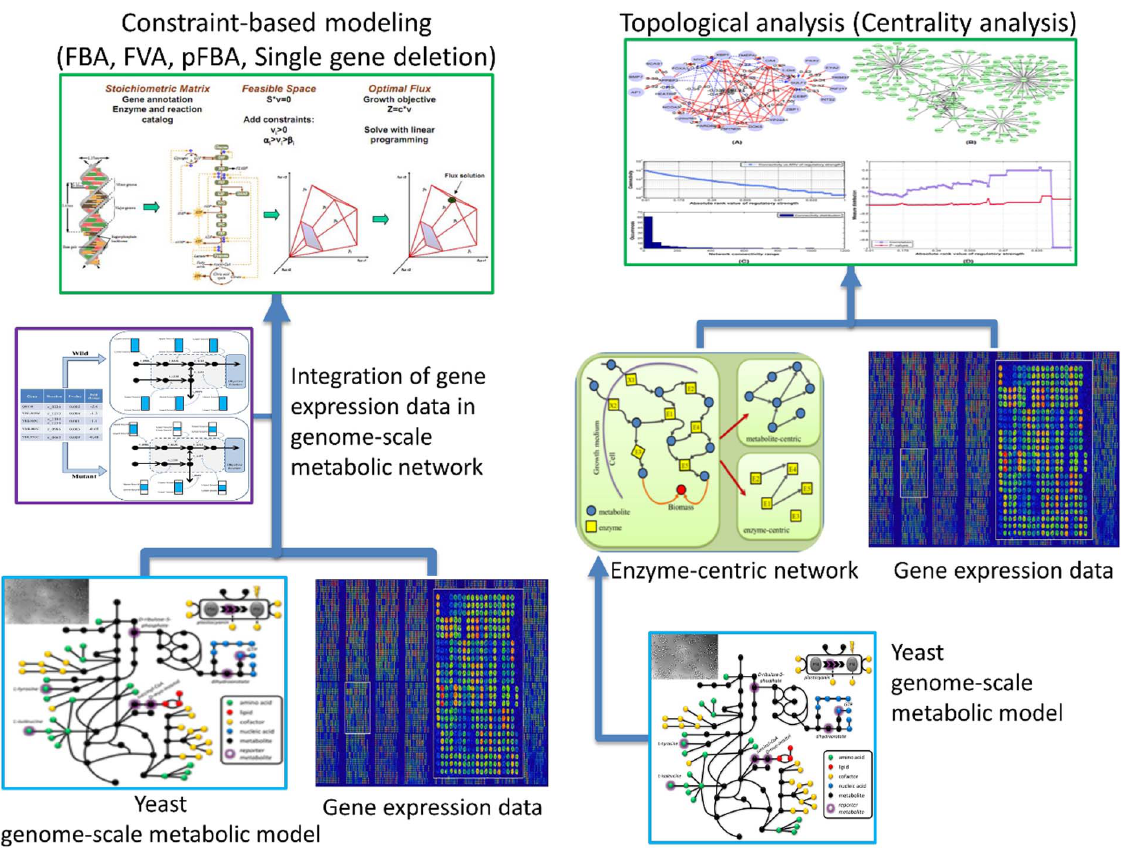
Table 1. Up and down significant metabolic genes in each group.